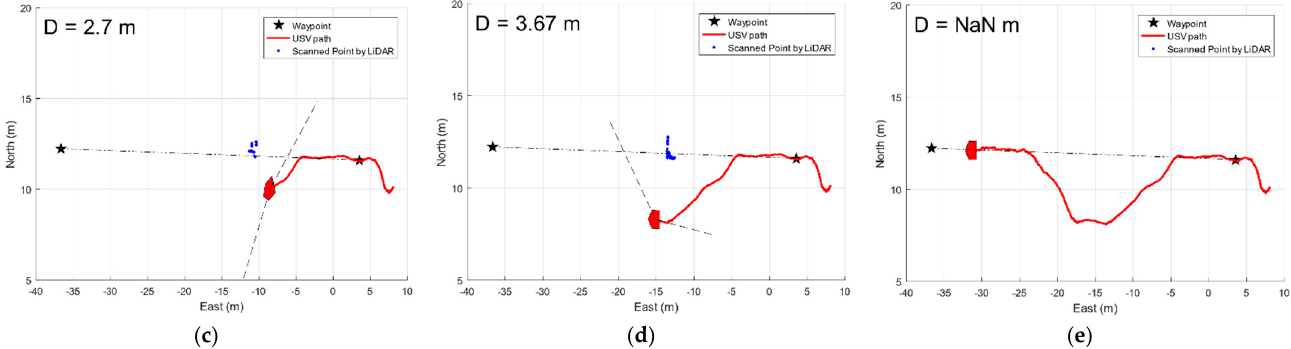
Figure 19. Dynamic obstacle avoidance in case of overtaking: USV2000 ′ s path (red) and obstacle’s path (yellow) are shown in ( a ); heading-tracking analysis in ( b ); obstacle avoidance process with evolving pair of avoiding directions (black) in ( c – e ).